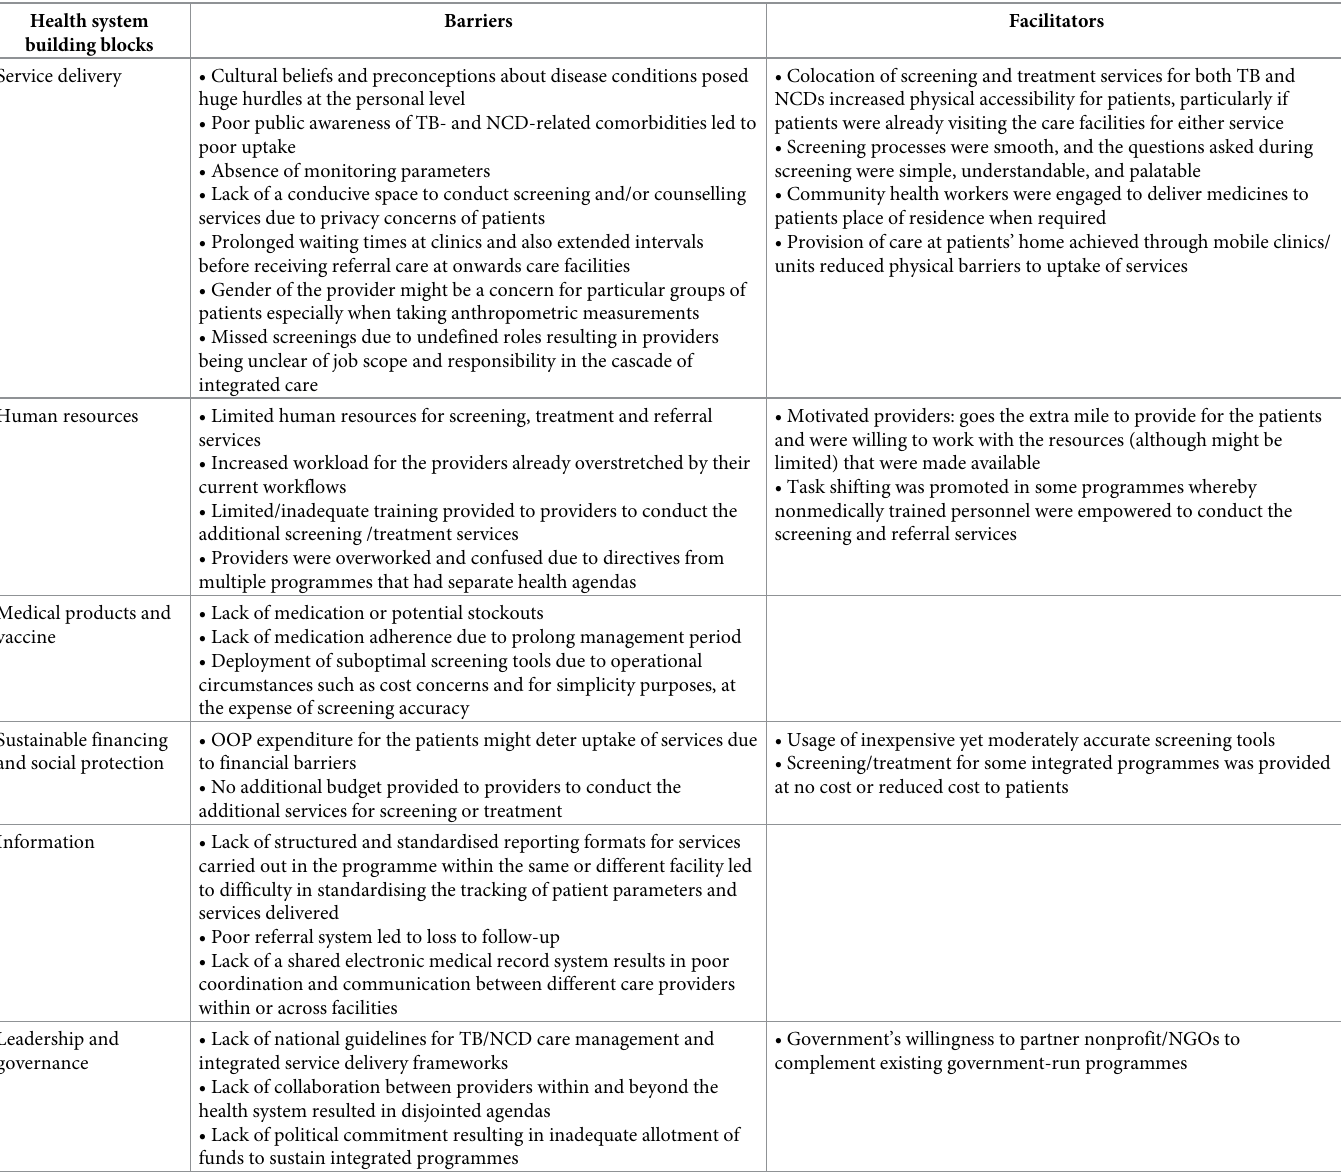
Table 7. Summary of facilitators and barriers mapped into WHO health system